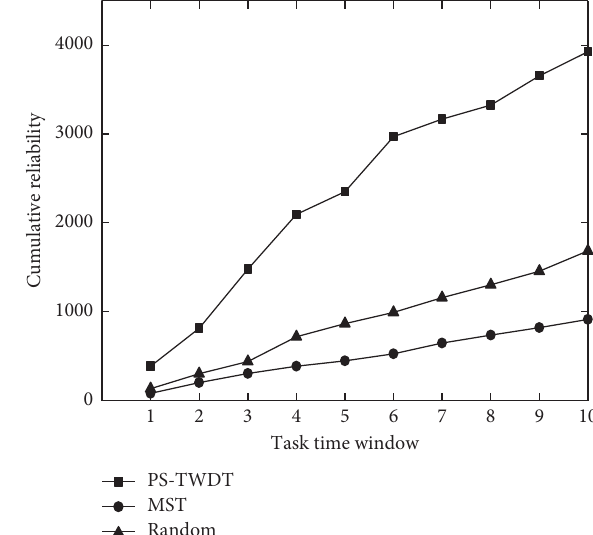
Figure 6: Ratio of number of participants in backup set to total number of participants.